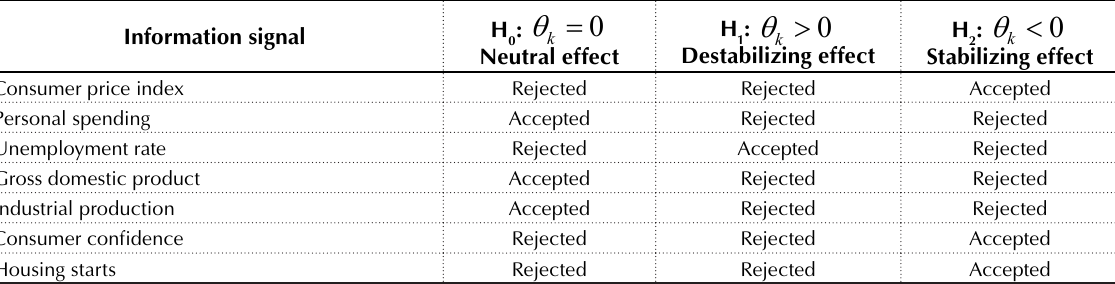
Table 4. The results of testing the hypotheses H component of the “surprise” of non-monetary information signals on stock quotes of enterprises of the economic sector “Basic